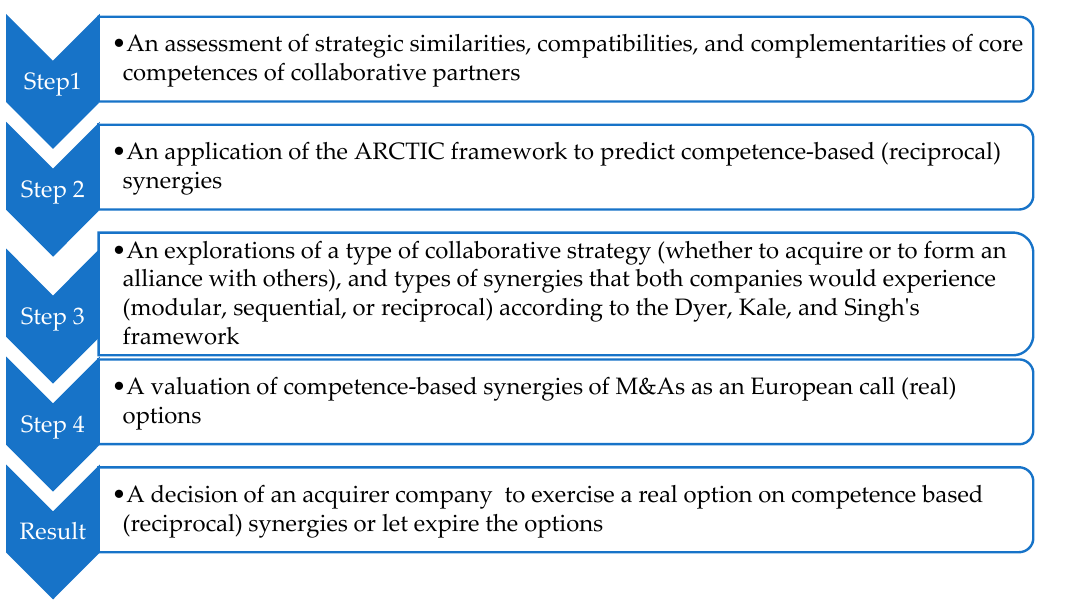
Figure 3. The relationships among developed steps for a preliminary assessment of the success of M&A deals.